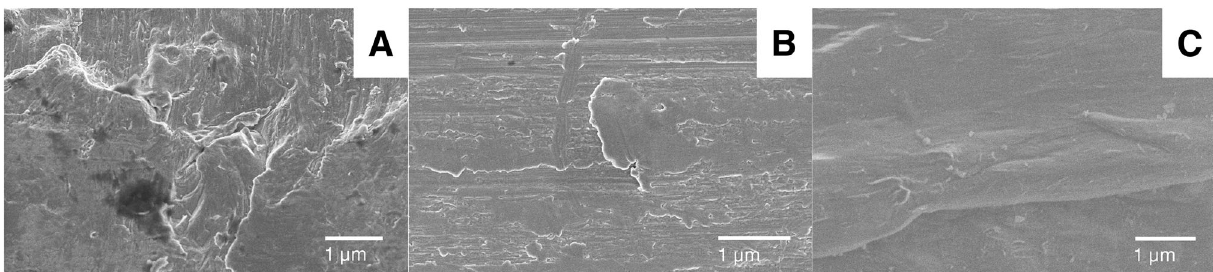
Fig. 8 SEM images of the substrates: A Blasted Ti, B Machined Ti, C Machined PEEK